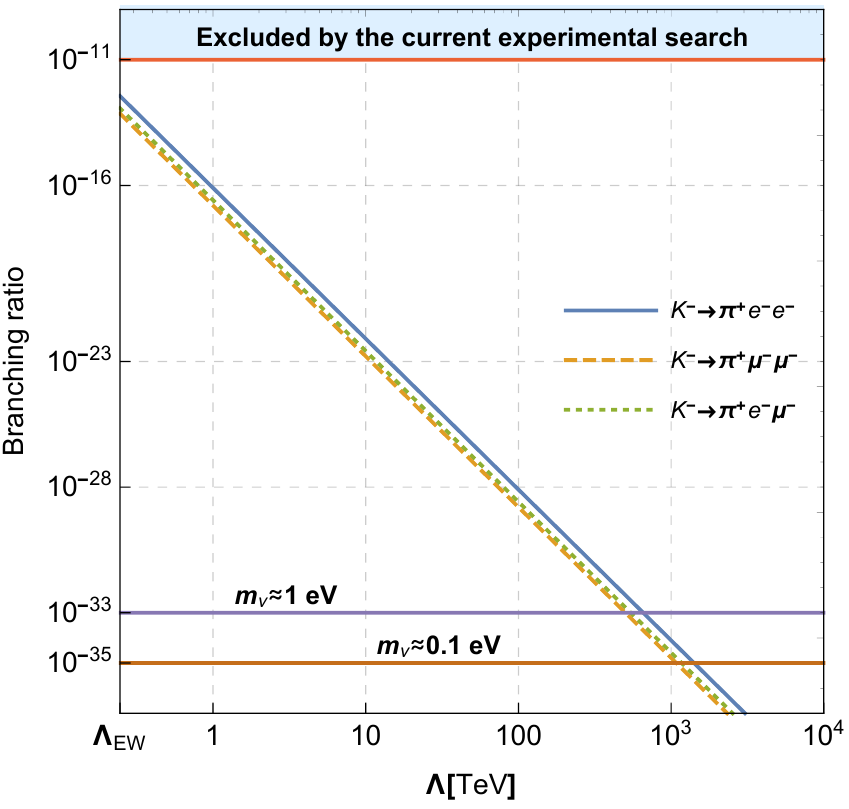
Figure 2 . Branching ratios for K (cid:0) ! (cid:25) + l (cid:0) (cid:3) in the SMEFT framework. Also shown are the current experimental bounds (upper horizontal line) and the neutrino mass contribution alone (lower horizontal